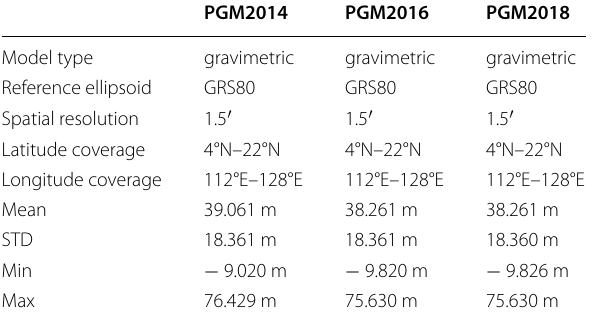
Table 1 Characteristics and statistics of the PGM gravimetric geoid series, considered as an example of the assessment of the evolution of local geoid models in time PGM2014 PGM2016